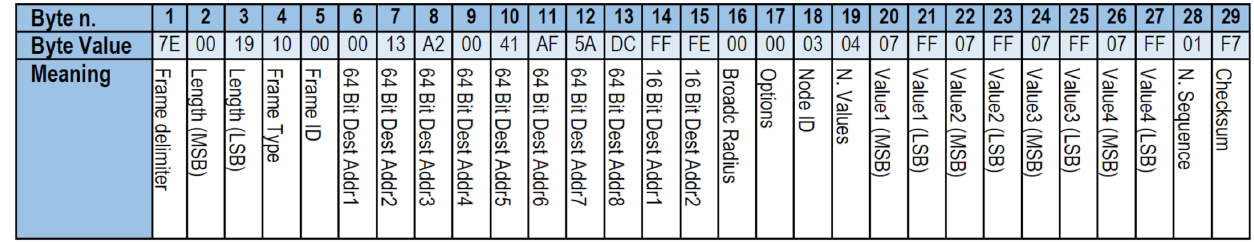
Figure 4. Frame used by the microcontroller at the Smart Measuring Nodes to send the values acquired from the sensors.